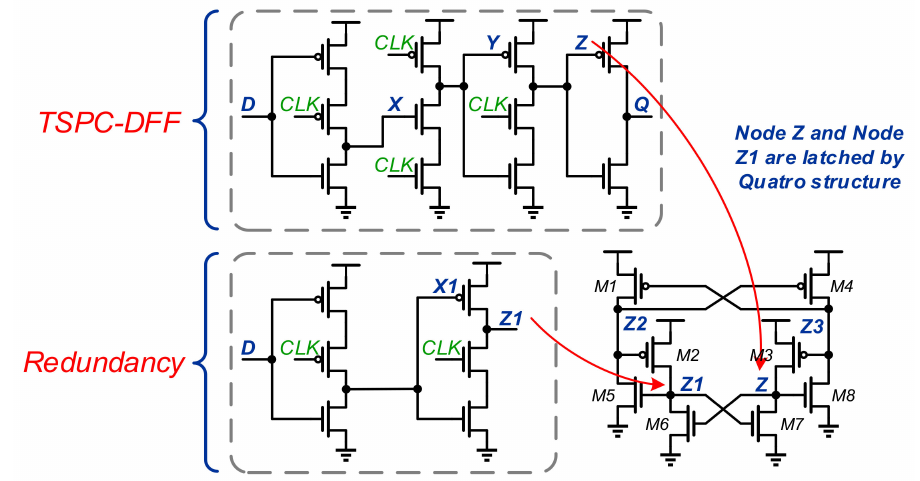
Figure 12. Schematic diagram of TSPC-Quatro.